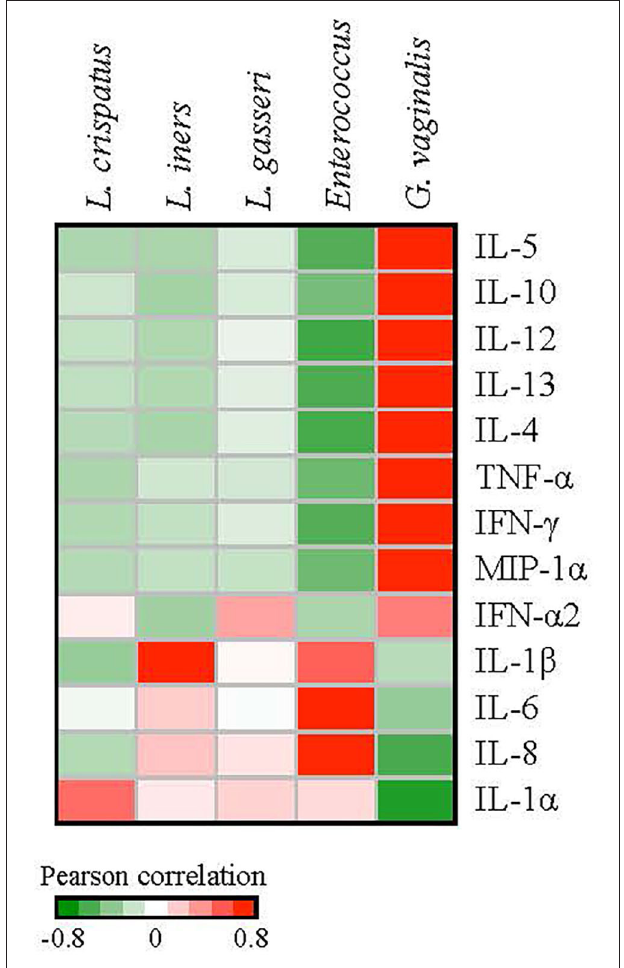
FIGURE 6 | Correlations between the relative abundances of vaginal bacterial species and cytokine expression levels. We used the median values of the relative abundances of bacterial species and the cytokine expression levels among the samples at each visit in the calculation of the Pearson correlation coefficients over the 8 clinic visits. G. vaginalis was significantly associated with IL-4 ( p = 0.003), IL-5 ( p = 0.004), IL-10 ( p = 0.02), -IL-12 ( p = 0.004), IL-13 ( p = 0.007), TNF- α ( p = 0.006), IFN- γ ( p = 0.005), and MIP1- α ( p = 0.02). Enterococcus was associated with IL-6 ( p = 0.01) and IL-8 ( p = 0.02). L. iners was associated with IL-1 β ( p =